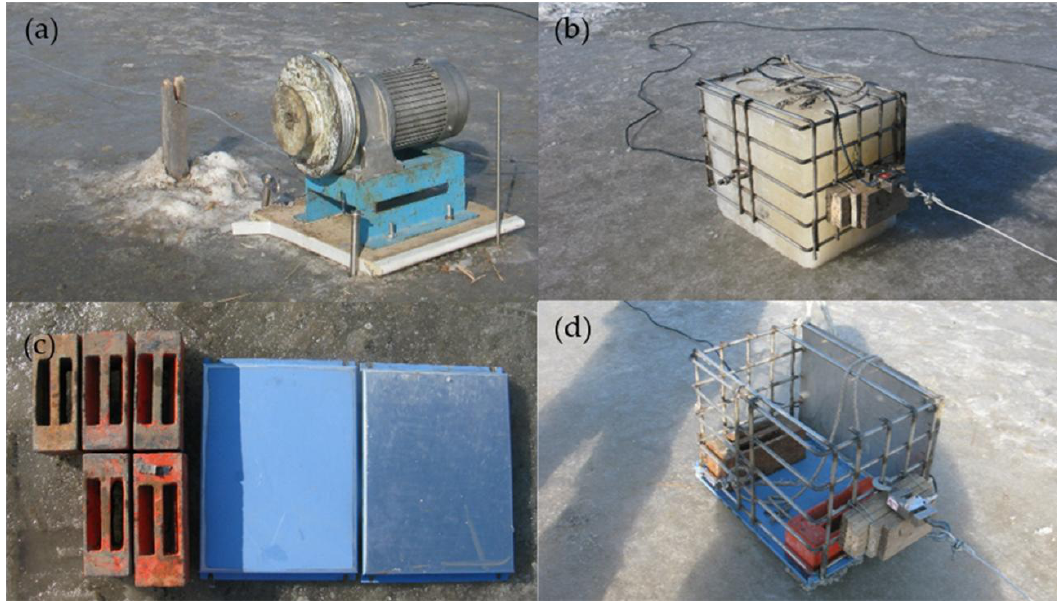
Figure 1. Field ice friction experiment: ( a ) gear motor; ( b ) ice block sliding on its bottom along the Top track; ( c ) iron blocks, coated steel (CS) plate (blue), and stainless steel (SS) plate (silver); ( d ) SS plate sliding along the Top track with two iron blocks inside.